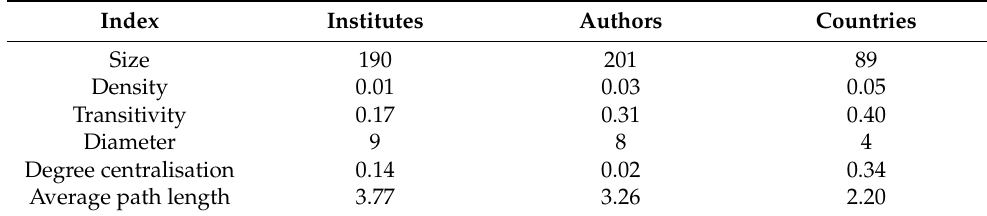
for a complete list of institutes. Table 4. Indexes of the collaboration